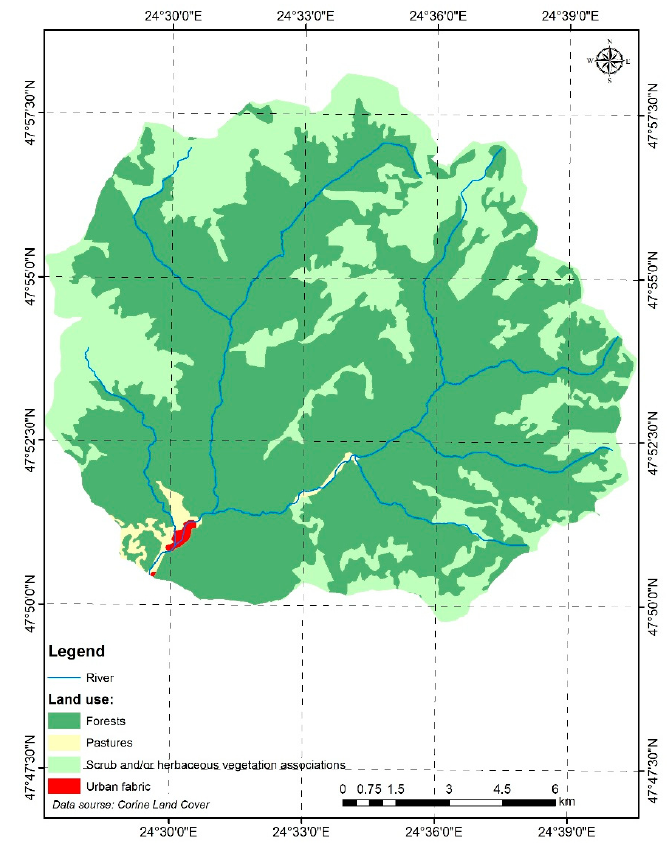
Figure 2. Land use of the Ruscova River according to Corine Land Cover 2018.